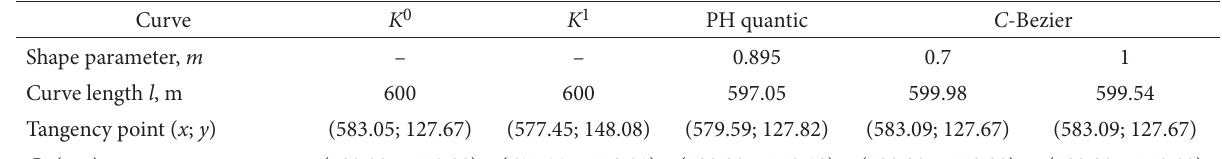
Table 2. Parameters of the constructed S -shaped curves Curve